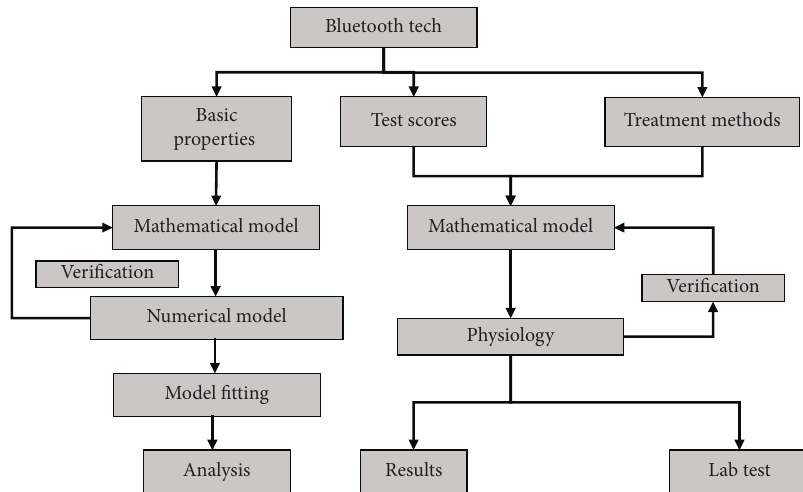
Figure 2: Bluetooth scanning handle graphic processing flow.